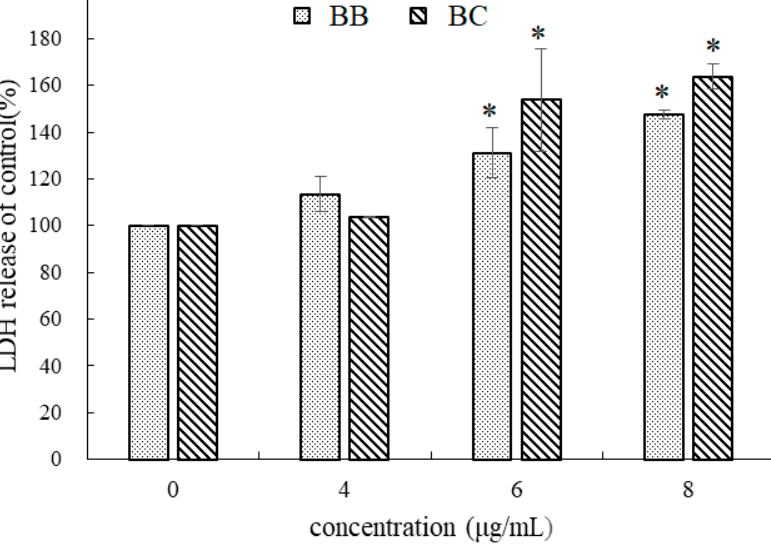
Figure 3. Changes of LDH release rate in BGC-823 cells after treatment by BB and BC (* p < 0.05). Morphological alterations are the cornerstone for identifying apoptosis and represent the most straightforward approach, featuring chromatin condensation, fragmented DNA, swollen mitochondria, or the emergence of apoptotic bodies. The cellular ultrastructure can provide a more detailed observation of the fine changes in cell structure following AMP treatment, thus corroborating the influence of AMPs on cell morphology. Observation of the effects of BB and BC on the ultrastructure of BGC-823 cells was conducted using transmission electron microscopy (TEM) (Figure 4). BGC-823 cells without treatment dis- played abundant and intact organelles, evenly distributed chromosomes in the nucleus, and clear nucleoli. The overall cell morphology was intact, with a rich population of mi- crovilli on the cell surface. However, after treatment with 6 µg/mL of BB, the number of